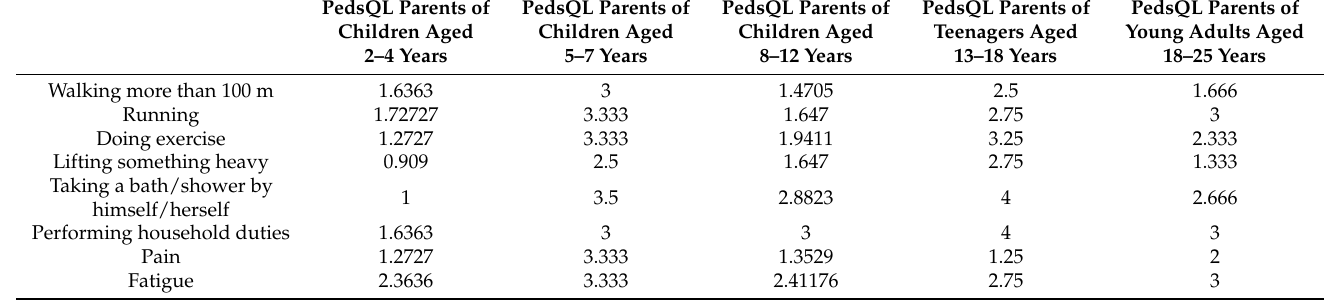
Table 5. Physical functioning in children with Dravet syndrome.